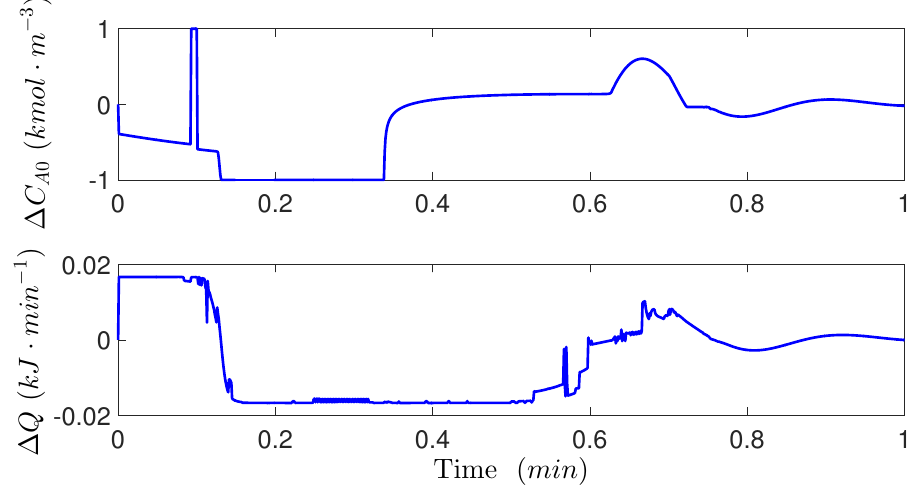
Figure 13. Manipulated input profiles ( u 1 = ∆ C A 0 , u 2 = ∆ Q ) for the initial condition (0.24, − 2.78) under the LMPC of Equation (14) and the NN-based detection system.